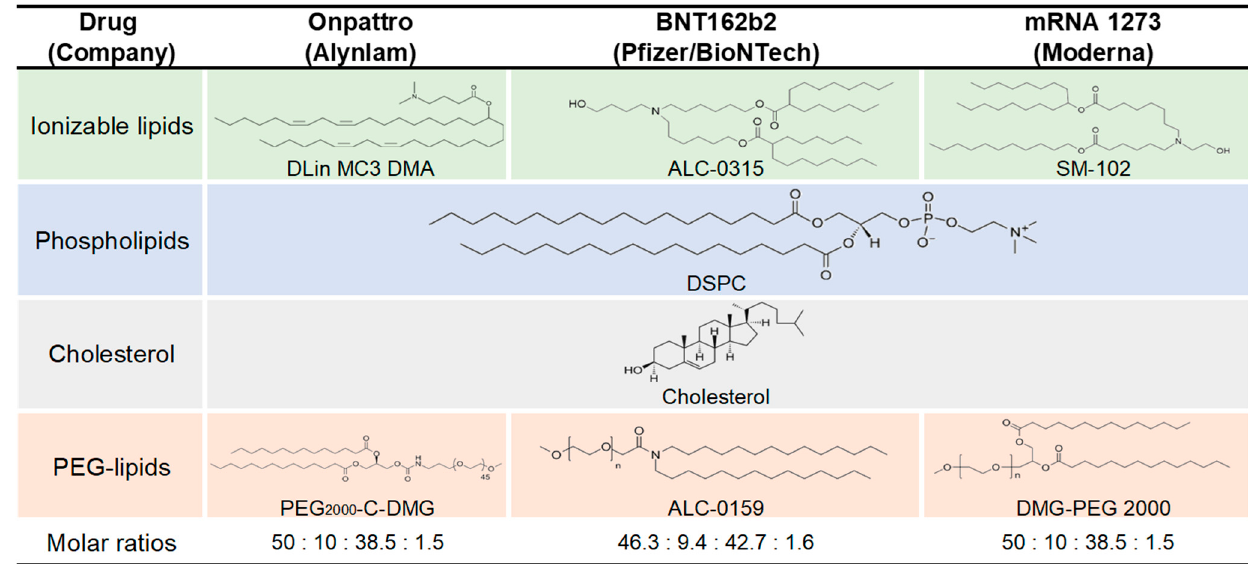
Figure 4. Molecular structures of lipids used in three FDA-approved clinical applications.